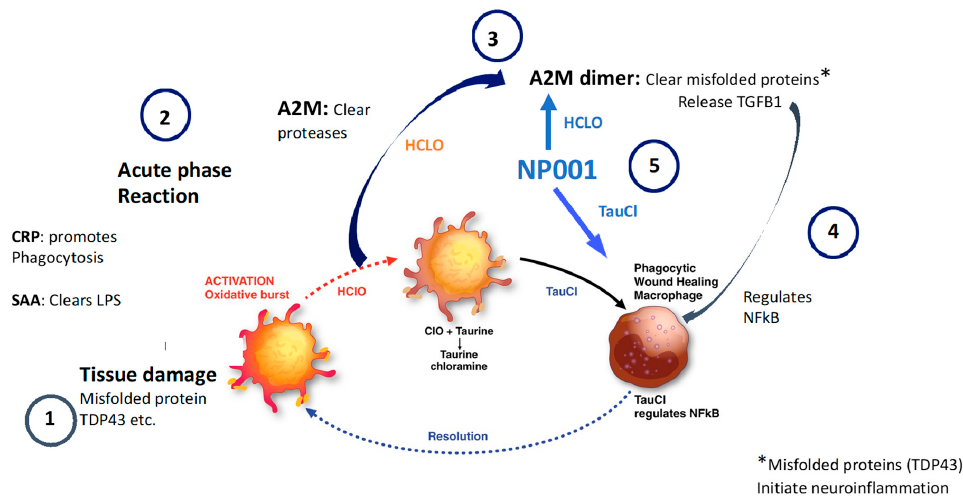
Figure 10. NP001 augments the innate immune activation cycle in ALS patients who have elevated baseline plasma CRP. Step 1: Blood derived macrophages become activated and begin clearance of cells and tissues containing pathogenic proteins and elaborate factors that initiate the acute phase reaction, producing hypochlorous acid as a byproduct of oxidative burst activation. Step 2: Rapid